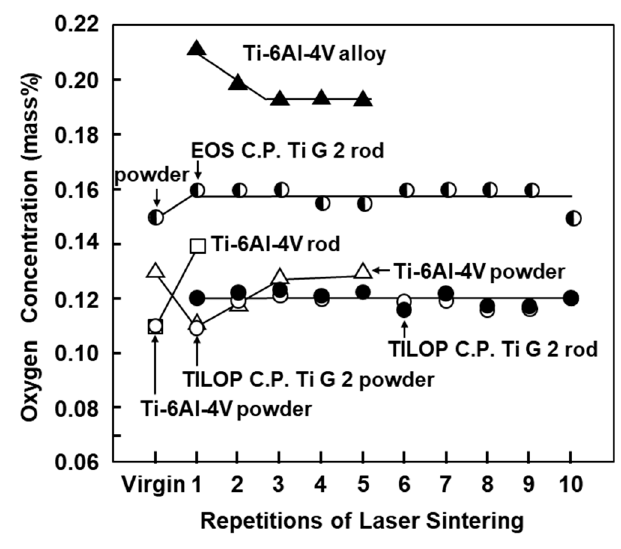
Figure 3. Effect of repeated laser sintering on oxygen concentration in Ti powders and laser-sintered Ti materials.